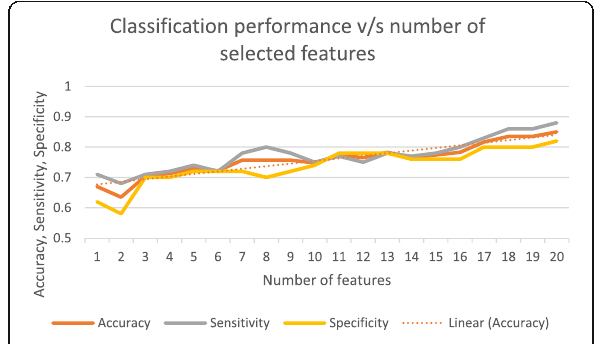
Fig. 5 Classification performance (accuracy, sensitivity, and specificity) of Relief-F method versus the number of selected